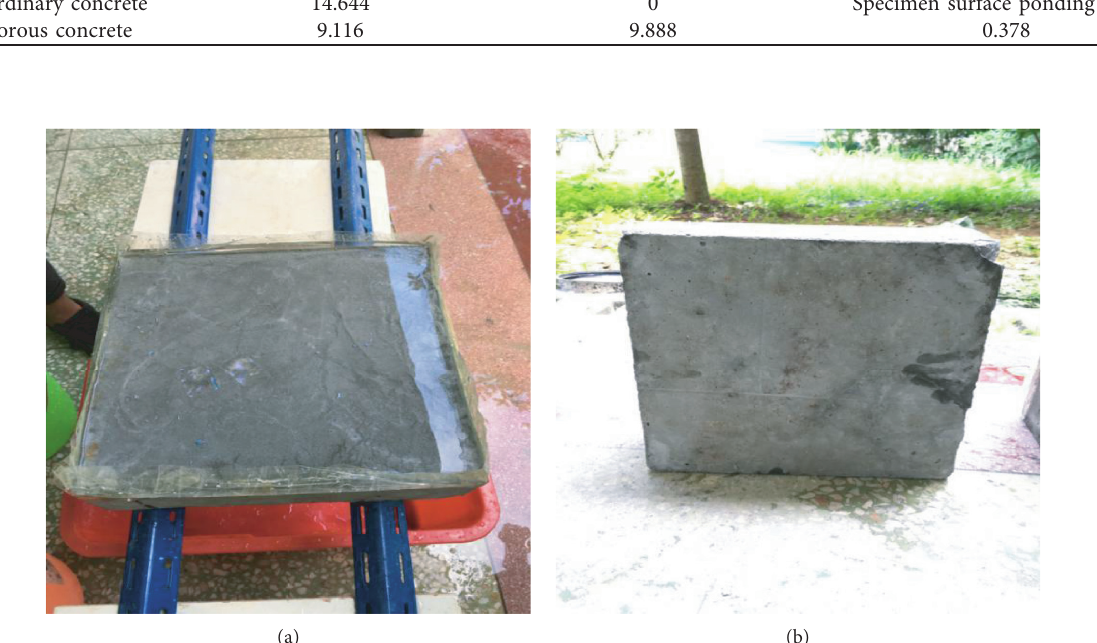
Figure 7: Ordinary concrete specimen after the test. (a) Specimen surface ponding is about 0.8 cm after the test. (b) The other side of the specimen is dry after the